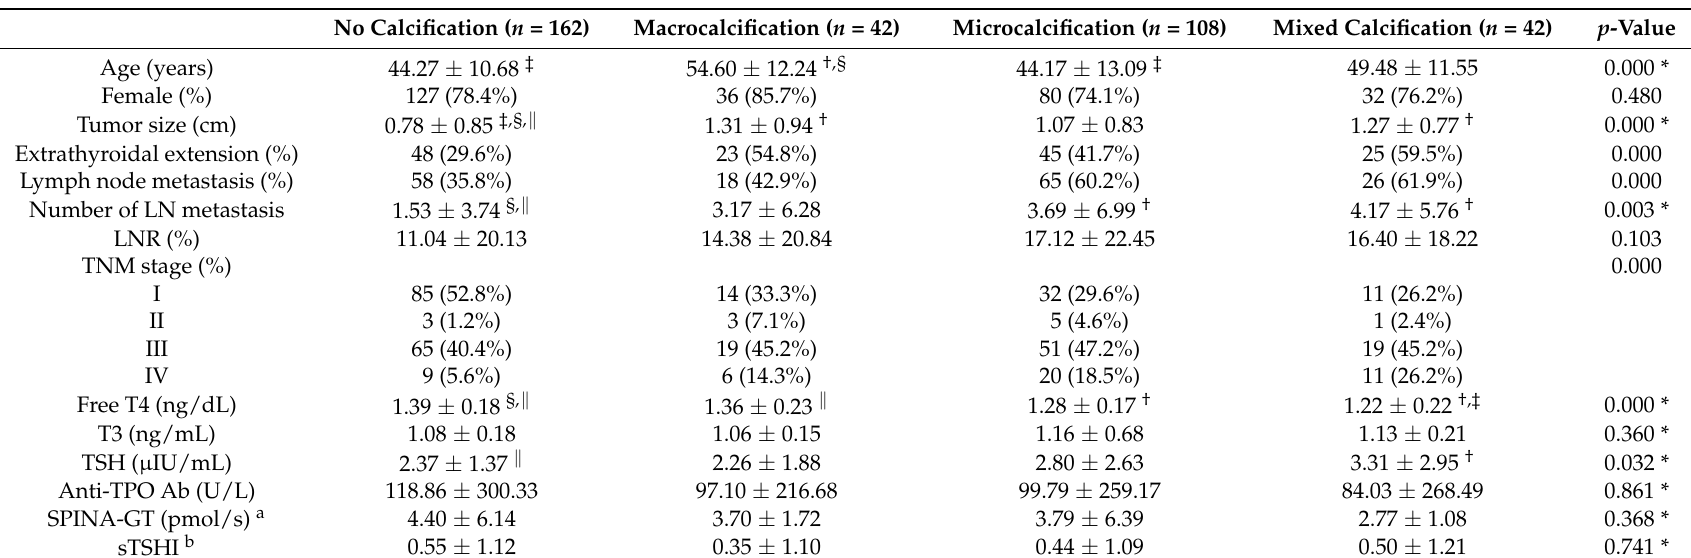
Table 3. Clinical differences between the four calcification patterns (Group